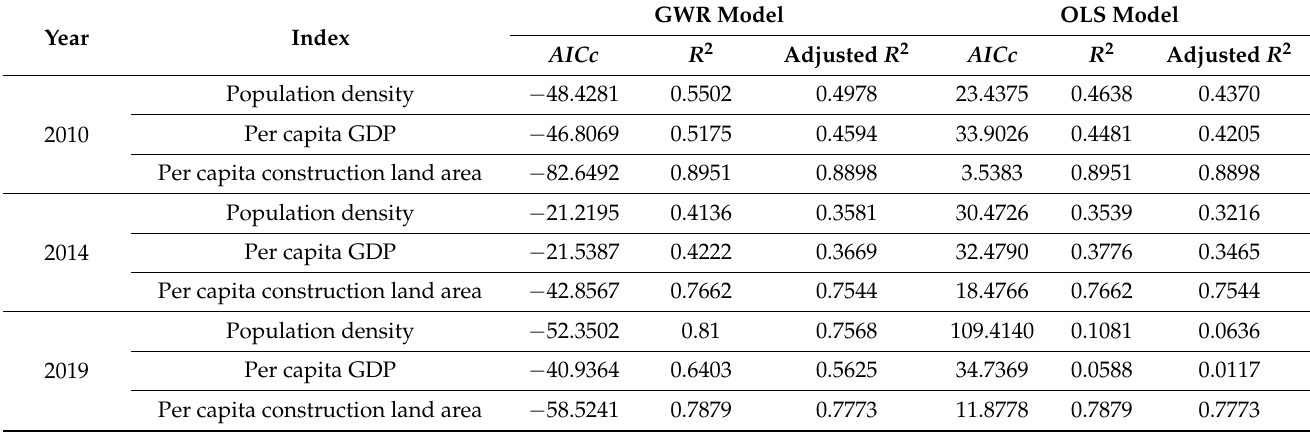
Table 7. The fitting parameters of the GWR model and OLS model (2010, 2014, and